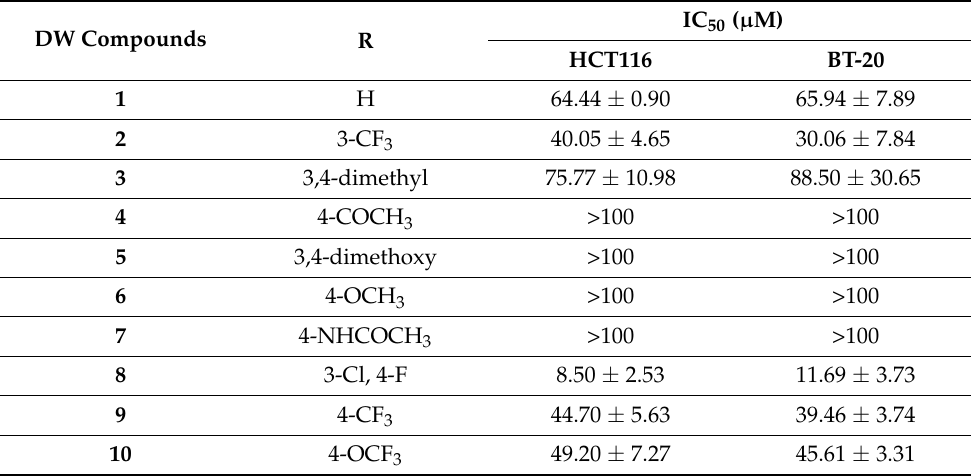
Table 1. The efficacy of 4-anilinoquinazoline compounds ( DW 1 – 10 ) in the colorectal cancer cell line, HCT116 and the breast cancer cell line,